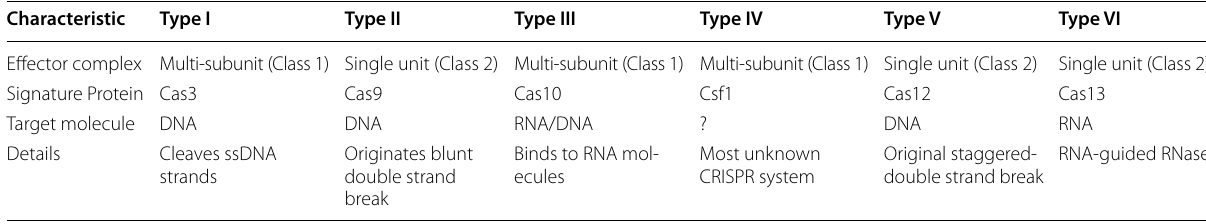
Source: Alexandre and Gabriela. (2019)